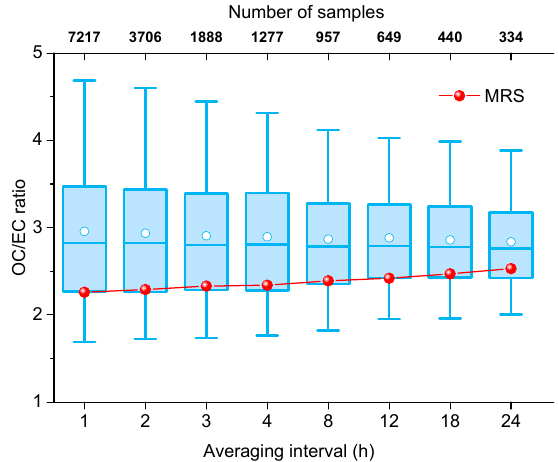
Figure 9. OC / EC distributions assuming different average inter- vals from 2 to 24h and the corresponding MRS-derived OC / EC pri . The bottom x axis represents averaging interval (e.g. 1h is the orig- inal data time resolution, 2h referring average 1h data into 2h interval data, etc.). The top x axis represents the number of data point corresponding to the respective data averaging interval. Dis- tributions of OC / EC ratio at various averaging intervals are shown as box plots (empty circles: average, the line inside the box: me- dian, the box boundaries: 75th and the 25th percentile, and the whiskers: 95th and 5th percentile). The red dots represent calcu- lated (OC / EC) pri by